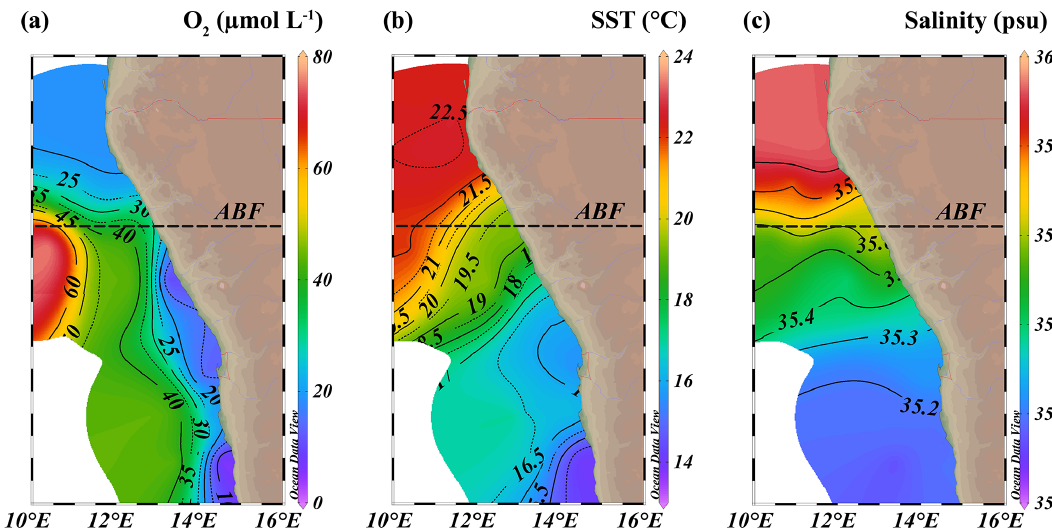
Figure 3. Isosurface plots of (a) minimum observed oxygen concentration in water column (µmolL − 1 ), (b) sea surface temperature (SST, ◦ C) and (c) maximum observed salinity in water column (psu). ABF: Angolan Benguela Front ( ∼ 19.8 ◦ S). Maps were created in ODV using the ETOP01_2min global tiles map 150 × 75 weighted average gridding (Schlitzer, R, Ocean Data View, https://odv.awi.de, last access: 12 June